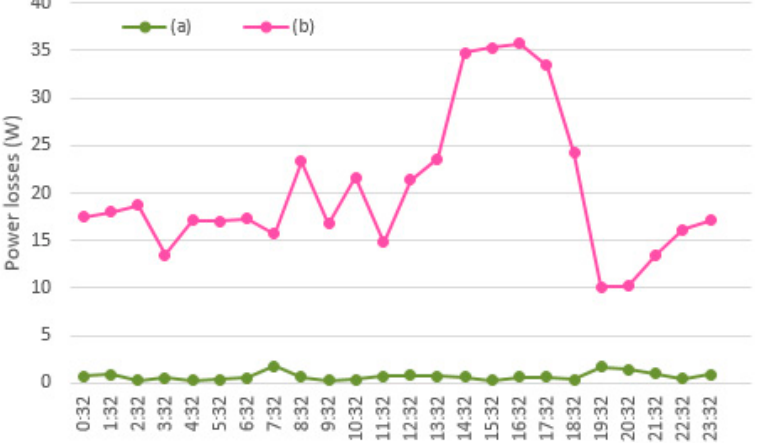
Figure 9. Transformer power losses, during holidays, caused by (a) unbalanced currents ( P cu ) and (b) distorted currents ( P ch ).